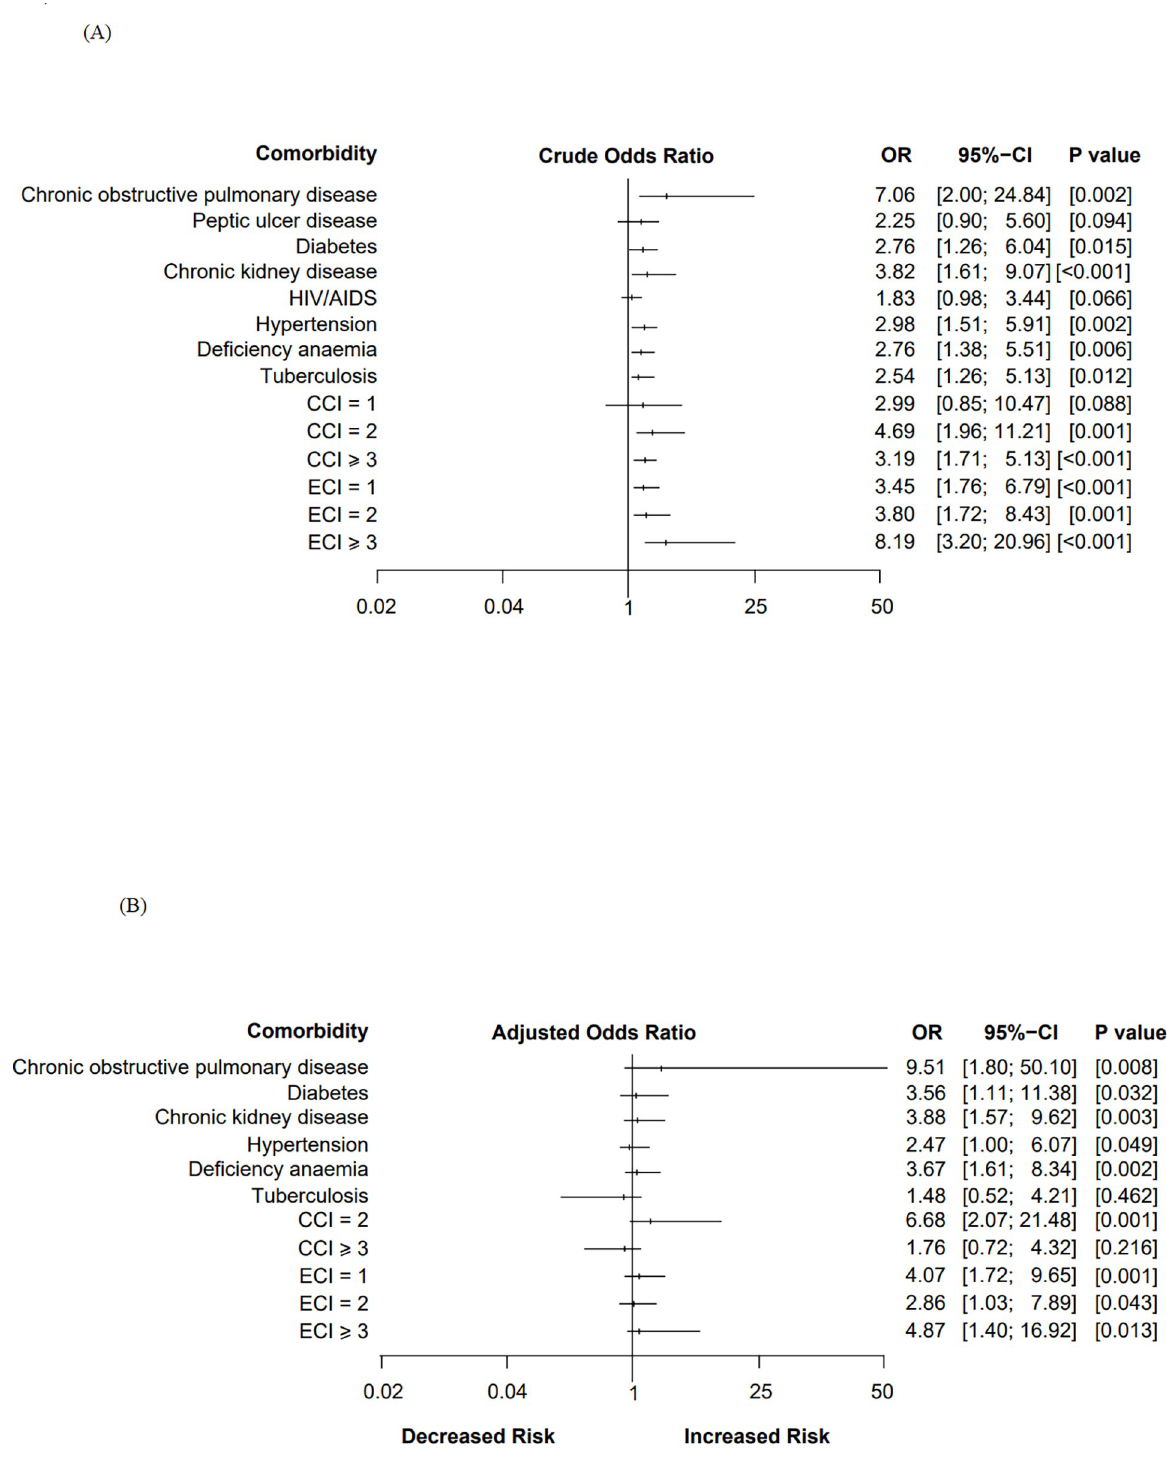
Fig 1. Forest plot depicting odds ratios (OR) with 95% confidence interval (95% CI) of predicting HO-CDI in patients with different comorbidity profiles. (A) Univariate logistic regression model showing unadjusted crude odds ratios. (B) Multiple binary logistic regression model showing adjusted odds ratios. The horizontal lines indicate the width of the confidence interval while the vertical marks on each horizontal line show the odds ratios. An odds ratio of more than 1.0 indicates increased risk. Abbreviations: OR- Odds ratio; CI- Confidence Interval; CCI, Charlson Comorbidity Index; ECI, Elixhauser Comorbidity Index; p -value indicating the level of statistical significance ( p < 0.05).